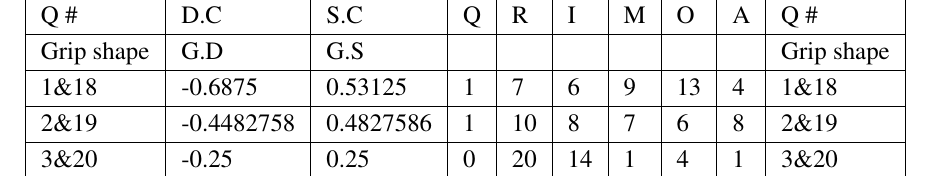
Table 7. Thearrangement of customers’ requirements and the values of satisfaction anddissatisfaction factor for grip shape